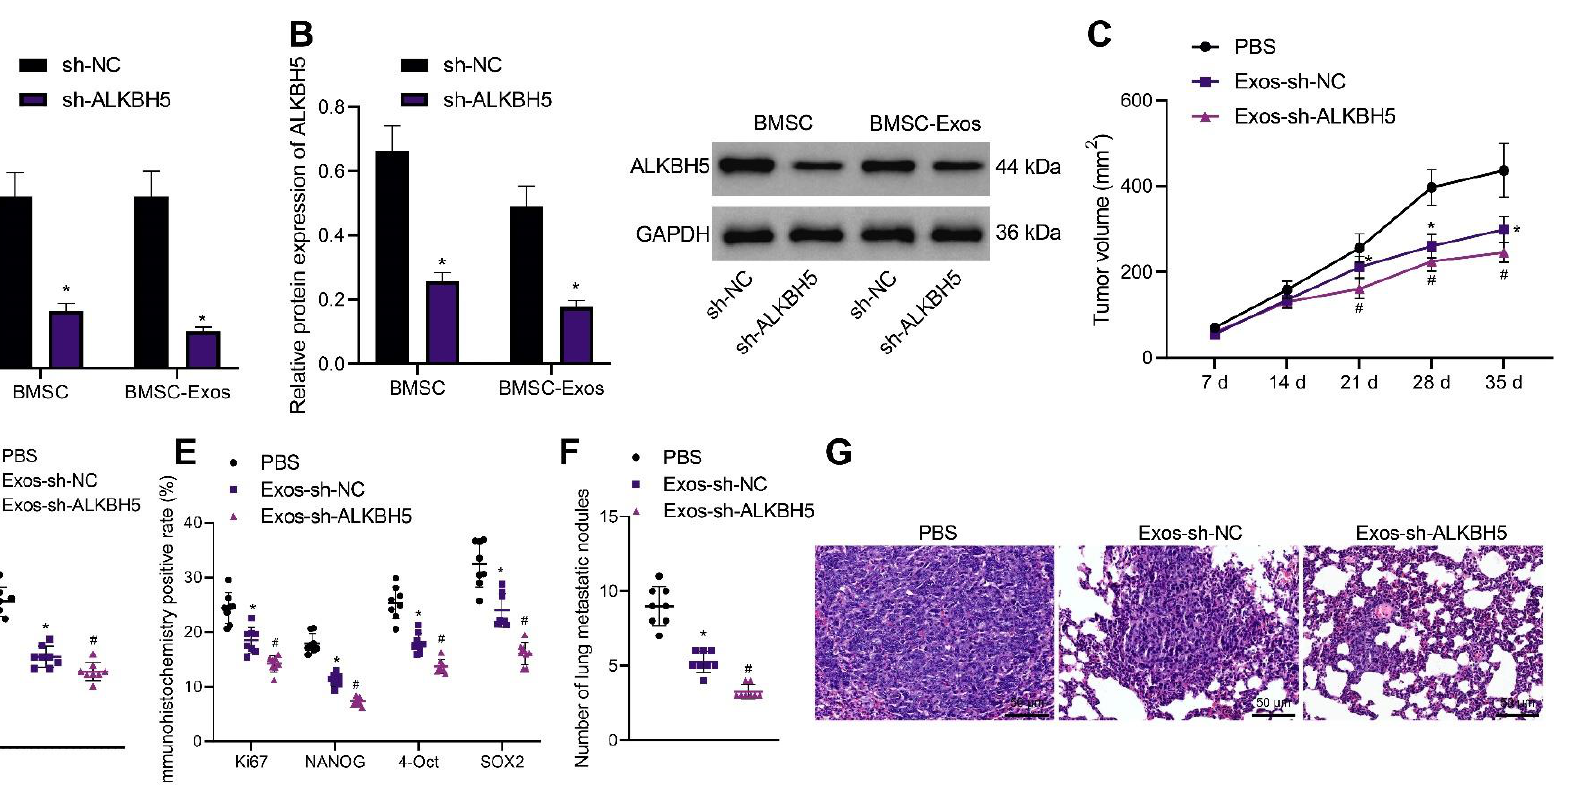
Figure 7. ALKBH5 shRNA-loaded BMSC-Exos reduces TNBC cell stemness and delays tumor growth and metastasis in vivo. ( A ): mRNA expression of ALKBH5 in the BMSCs and BMSC-Exos following ALKBH5 silencing determined by qRT-PCR; ( B ): The protein expression of ALKBH5 in BMSCs and BMSC-Exos following ALKBH5 silencing determined by Western blot; Mice were treated with ALKBH5 negative control-loaded BMSC-Exos (Exos- sh-NC) or ALKBH5 shRNA-loaded BMSC-Exos (Ex-os-sh-ALKBH5). ( C ): Tumor volume of mice; ( D ): Tumor weight of mice; ( E ): Positive expression of Ki67, NANOG, OCT4, and SOX2 proteins in the tumor tissues of mice determined by immunohistochemistry; ( F ): Statistics of number of lung metastatic nodules in mice; ( G ): Lung metastasis of breast cancer cells analyzed by HE staining. n = 8. * p < 0.05, compared with the mice treated with PBS and # p < 0.05, compared to the mice treated with Exos-sh-NC. Measurement data are expressed as mean ± standard deviation and comparisons between multiple groups were conducted by one-way ANOVA or repeated measures ANOVA. Statistical comparison was performed using unpaired t-test when only two groups were compared.